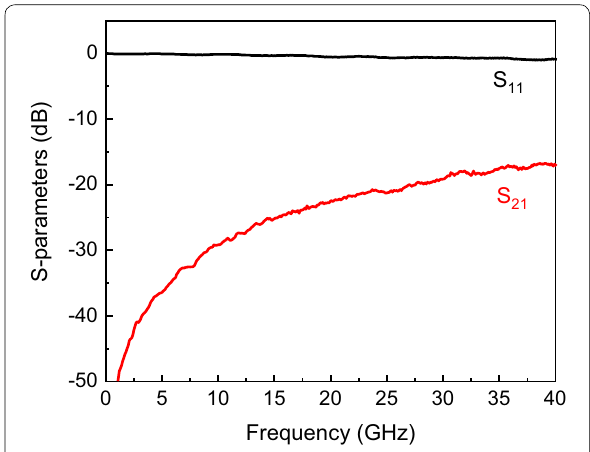
Fig. 10 Comparison of insertion losses between an RF‑MEMS switches with Au–Au contacts and an RF‑MEMS switch with Au–Au/ CNT‑composite